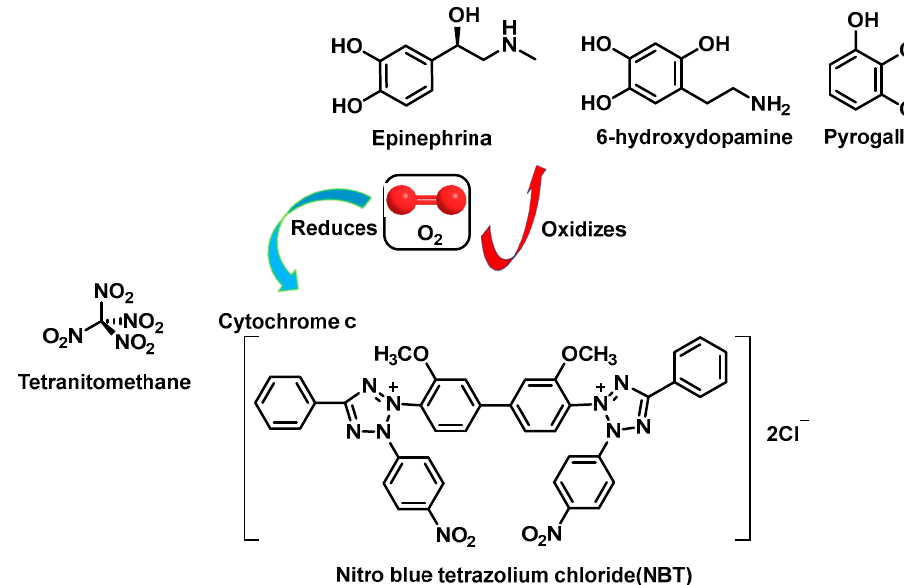
Figure 38. O 2 as a monovalent oxidant or